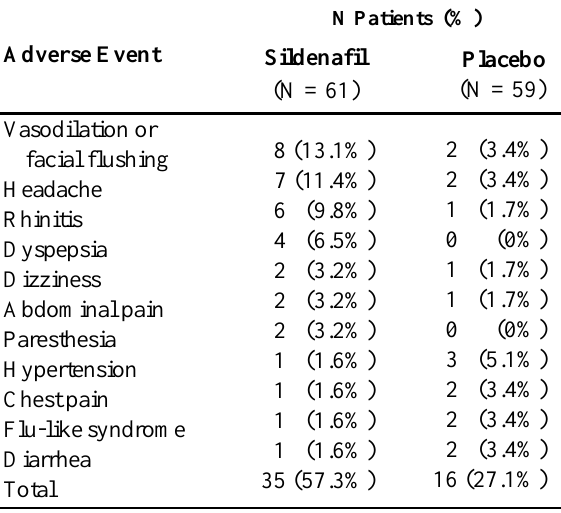
Table 4 – Adverse events occurring in 2% or more of patients (intent-to-treat sample, N =